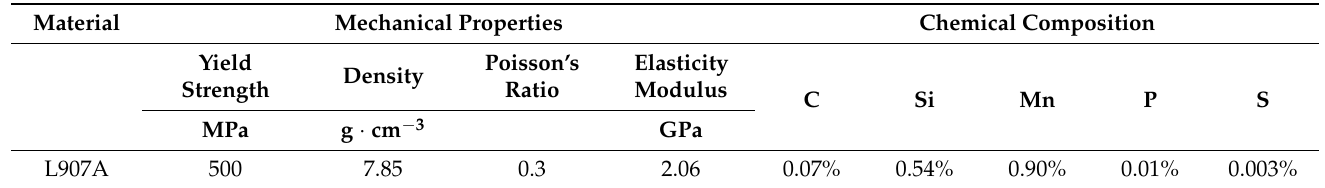
Figure 1. Geometric model of the stiffened plate. ( a ) Isometric view of the model; ( b ) three-view of the model. Table 1. Dimensions of the specimen. Table 2. Mechanical properties and chemical composition of L907A steel.